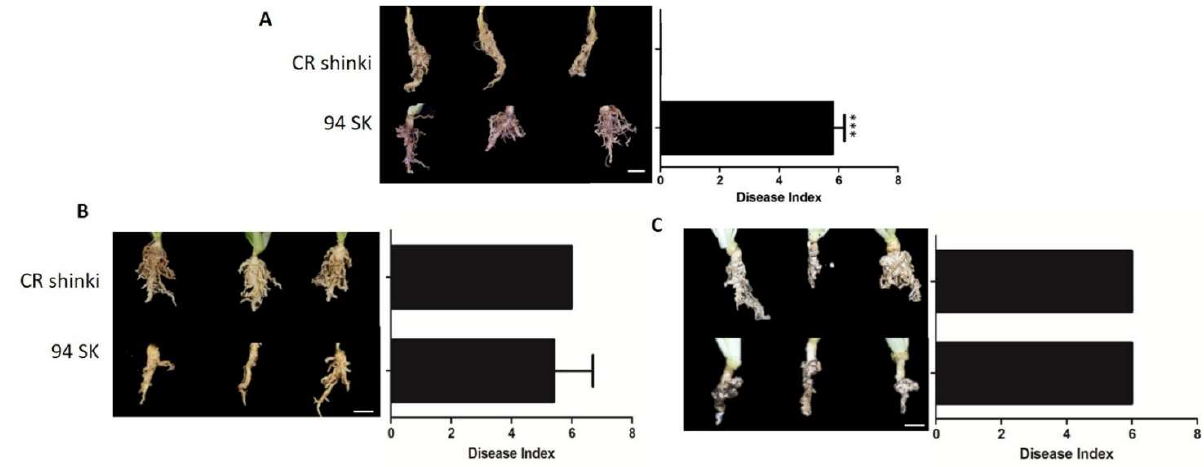
Figure 1. Differences in the responses of CR Shinki (resistant) and 94SK (susceptible) Brassica rapa inbred lines to three Plasmodiophora brassicae pathotypes. Disease symptoms on B. rapa roots infected with P. brassicae pathotypes ( A ) Race 4 [8], ( B ) Uiryeong, and ( C ) Banglim [54]. Disease severity was assessed according to the degree of root morphological modifications using the following rating scale: 0 = no symptoms; 1 = very slight swelling, usually confined to the lateral roots; 2 = a few small, separate globular clubs on the lateral roots; 3 = moderate clubbing on the lateral roots; 4 = large clubs on the lateral roots and slight swelling of the main root; 5 = larger clubs on the main root than on the lateral roots; 6 = severe clubbing on all roots. The mean disease index ( n = 10) is presented to the right of the photos; the bar represents the standard error of three replicates. Asterisks indicate a significant difference at p < 0.001.